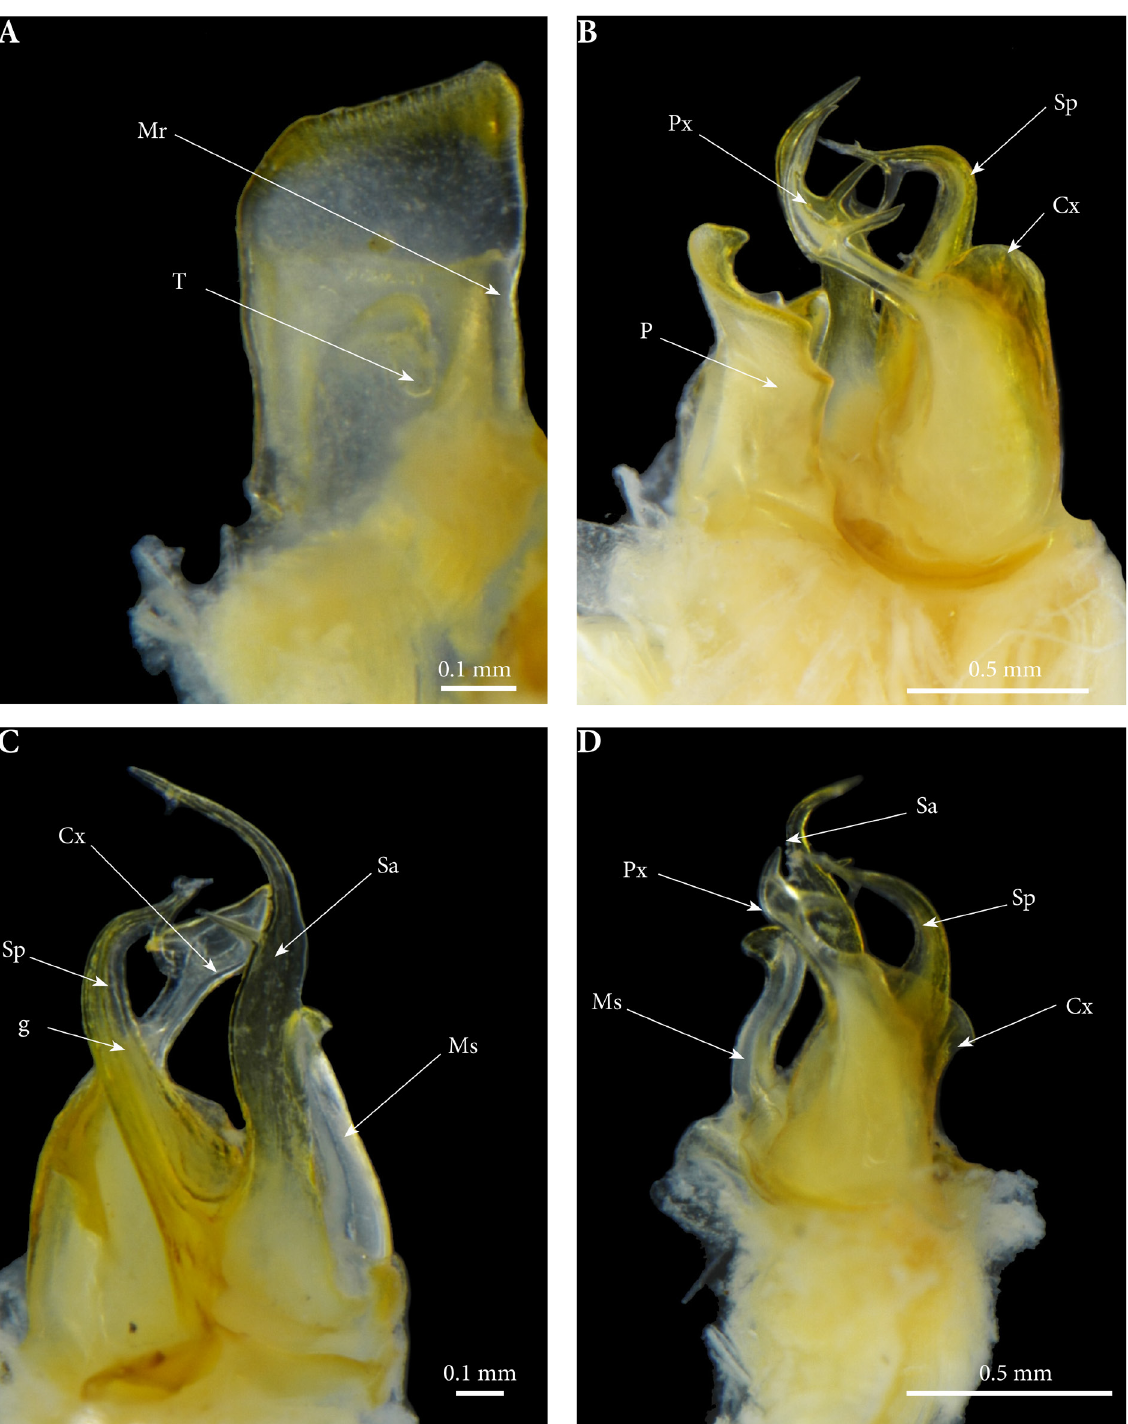
Fig. 20. Ommatoiulus staglae sp. nov. A . Holotype, ♂, right promerite, posterior view. B . Paratype, ♂, right gonopod, lateral view. C–D . Holotype, ♂, right posterior gonopod. C . Mesal view. D . Lateral